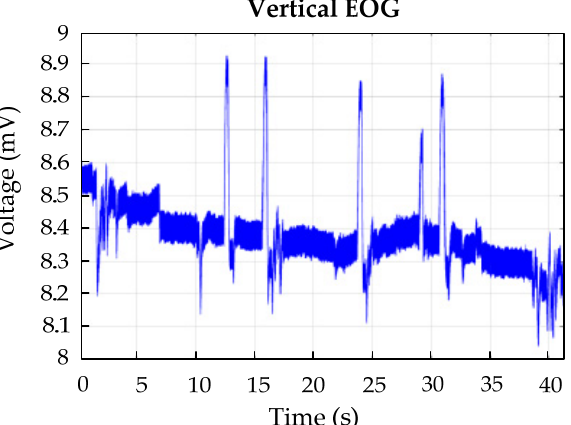
Figure 5. Example of blinking’s effect on the vertical derivation.